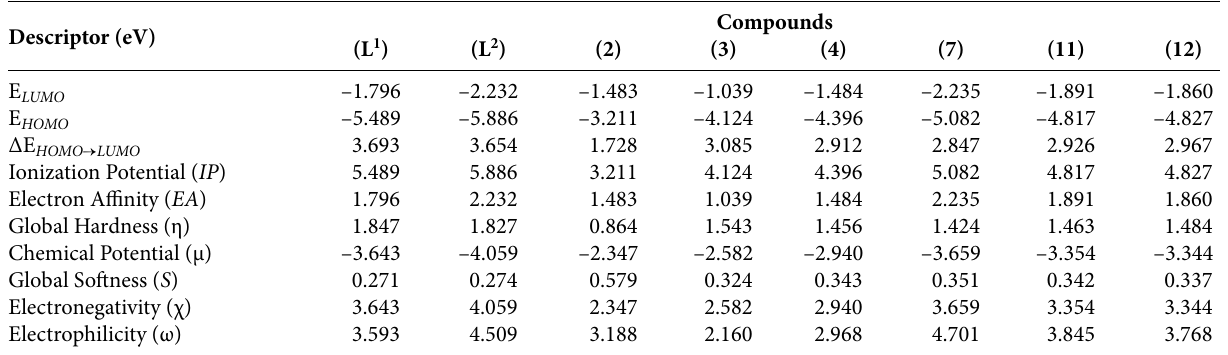
Table 3. FMO energies and their energy gaps (∆E) for phenylenediamine based ligands and their selected metal complexes Descriptor (eV)